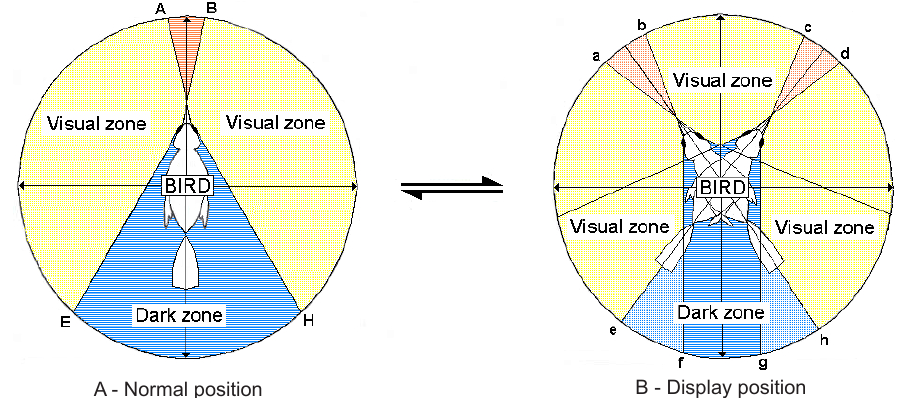
Figure 4. Diagrammatic presentation of tentative visual and dark zone in Red-vented Bulbul. [A] In normal position bird can scan approx. 275° to 300° (E to H, clockwise) including zone of binocular vision (A to B). [B] During the display, cyclopean area increased about 300° to 340° (f to g, clockwise) and blind/dark zone decreased approx. 60° (e to h, anticlockwise) to 20° approx (f to g, anticlockwise). The zone of binocular vision approx. 30° (A to B) also increased about 60° more (b to c,